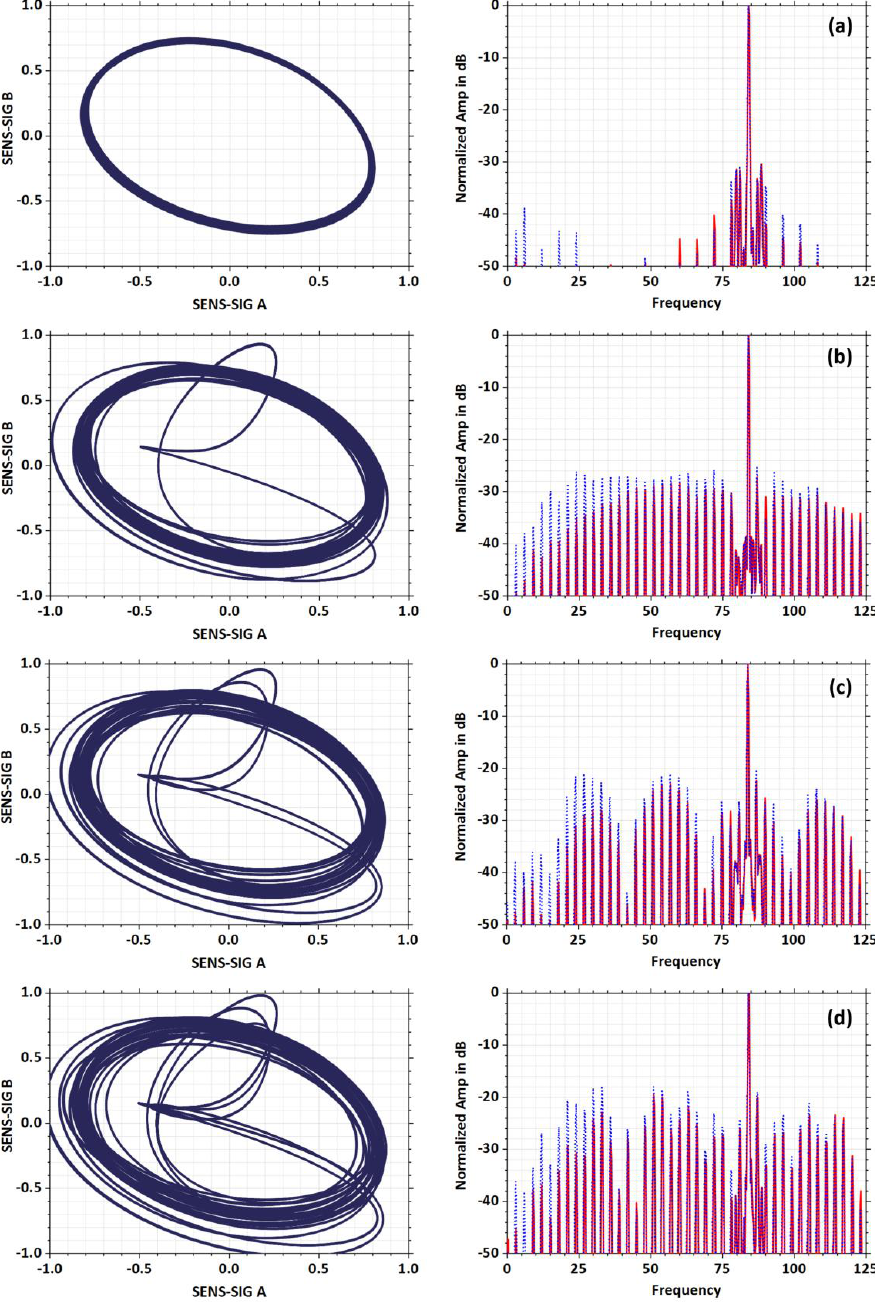
Figure 21. Comparison of FFT and oval patterns for the selected number of broken bars: ( a ) Reference oval pattern for rotor without defect; ( b ) 1 Broken bar; ( c ) 2 Broken bars; ( d ) 3 Broken